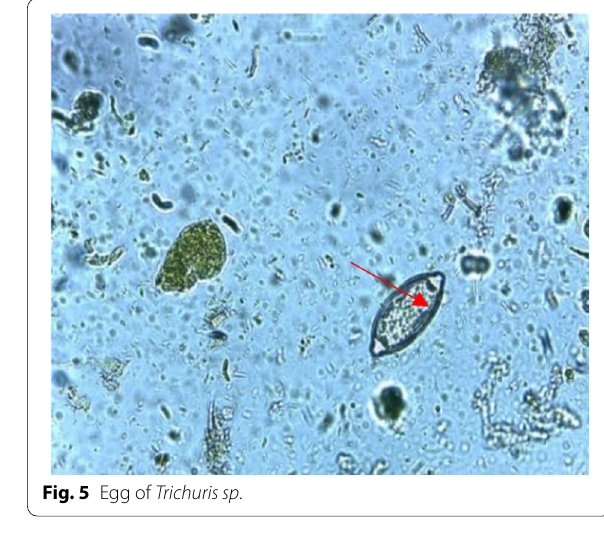
Fig. 3 Egg of Hymenolepis sp .